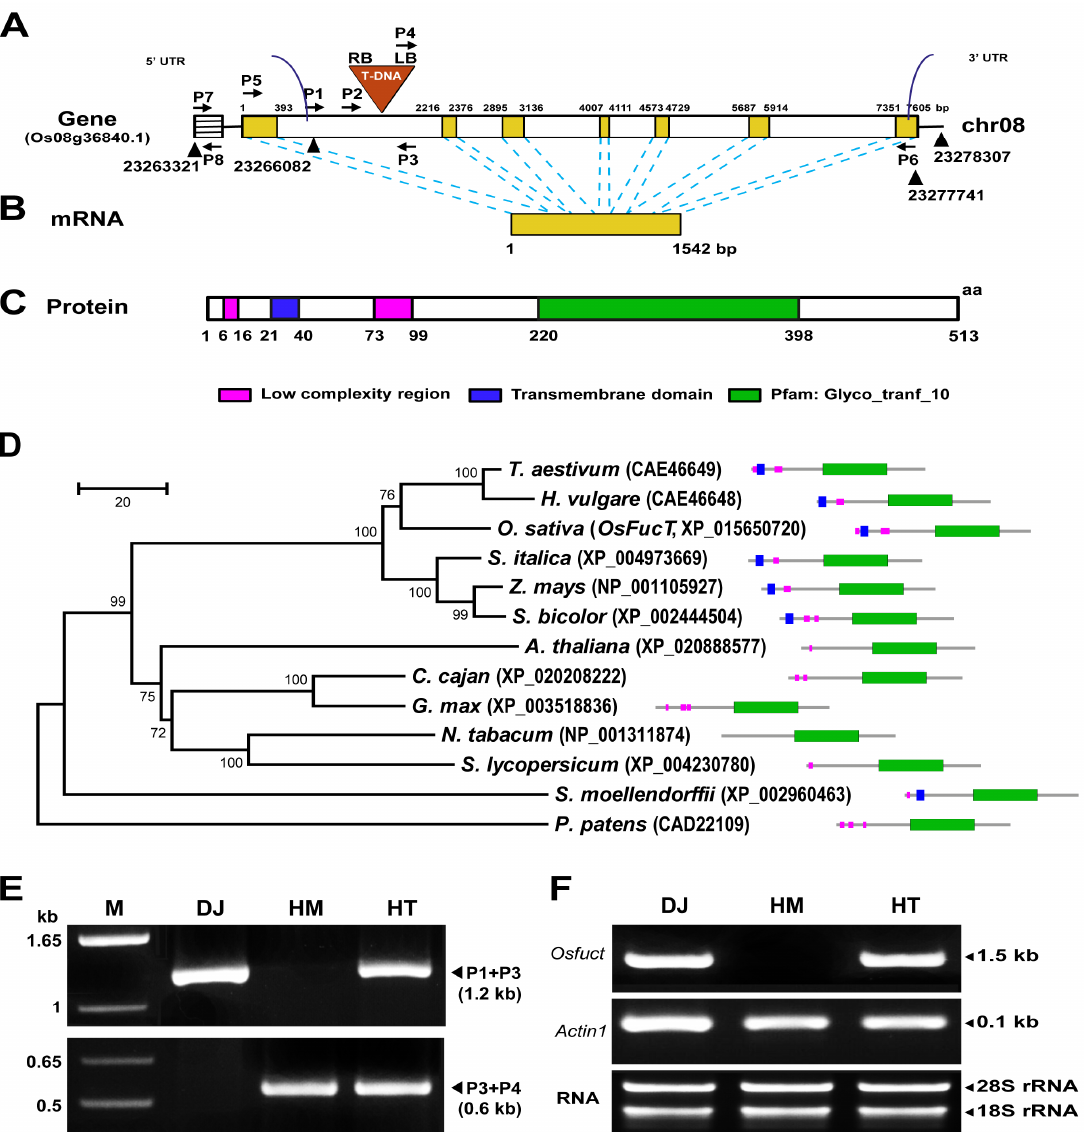
Figure 1. Identification and genotyping of the T-DNA insertion Osfuct mutant in rice ( Oryza sativa ). ( A ) Schematic representation of the genomic structure of the Osfuct and T-DNA insertion sites. Black-lined box represents promotor, while the yellow box indicates exons, and the white box represents the introns. Locations of the T-DNA insertion and direction of the left and right borders are indicated by an inverted triangle. Gene-specific (P1, P2, and P3) and T-DNA border sequence primers (P4) were used for genotyping and gene-specific primers (P5 and P6) were used for reverse transcription polymerase chain reaction (RT-PCR) analysis as indicated by the black arrowhead. ( B ) Yellow box with black border represents the full length of the cDNA (1542 bp). ( C ) SMART annotation for the OsFucT protein. Magenta box indicates the low complexity region, blue box shows transmembrane domain, and the green box represents the conserved glycosyltransferase domain (220–398 amino acids). ( D ) Phylogenetic analysis of OsFucT with other glycosyltrasnferase proteins. ( E ) Genotyping of homozygote (HM) and heterozygote (HT) plants to confirm the T-DNA insert. The upper lane PCR products were amplified using gene-specific primers P1 and P3 (1.2 kb), whereas the lower lane PCR products were amplified using the gene-specific primer P3 and T-DNA border sequence primer P4 (0.6 kb). ( F ) Expression analysis of Osfuct in Dongjin (DJ), HM and HT lines was done using RT-PCR. The expression level of actin1 was used as a loading control and gene specific primers (P5 and P6) were used for RT-PCR analysis.